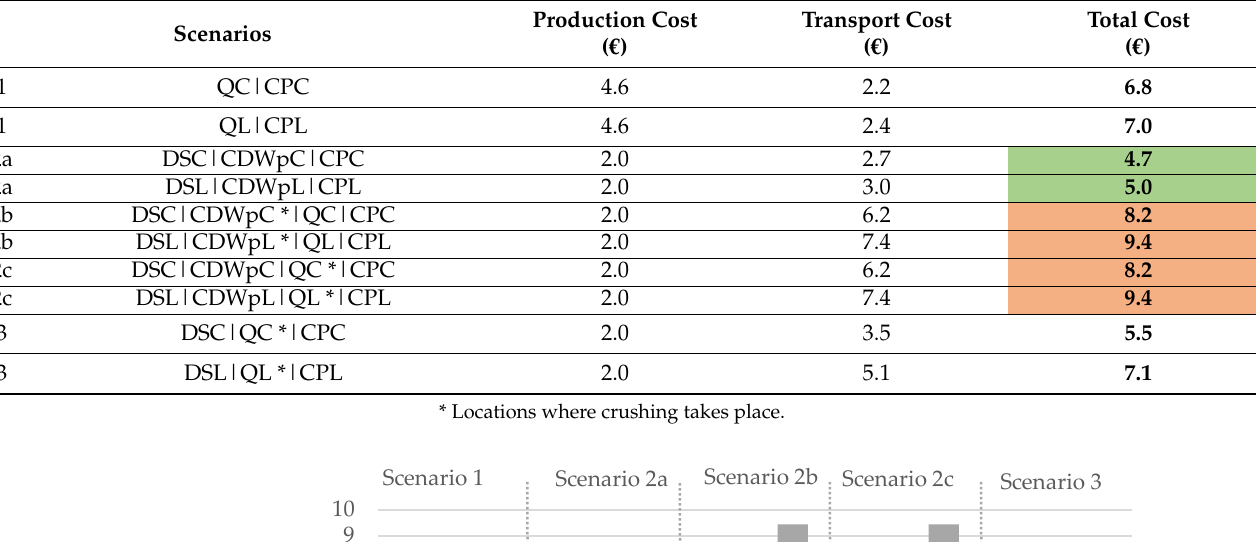
Table 6. Cost for production and transport of 1 tonne of aggregates.